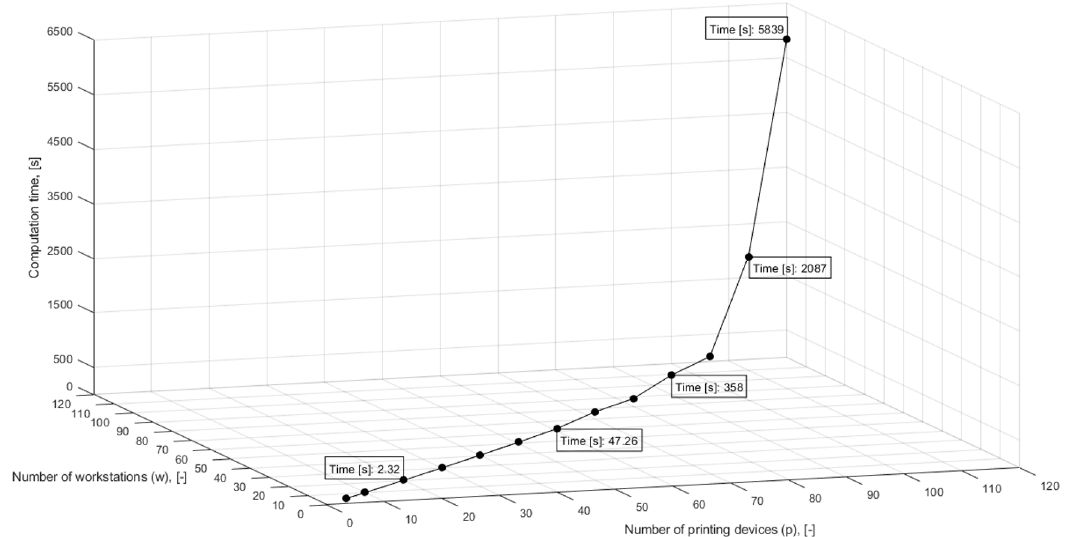
Figure 4. Model computation time as a function of the number of printing devices and the number of workstations.